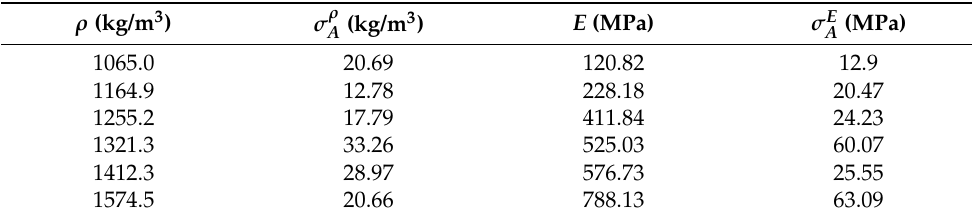
Figure 9. Approximate section describing the variance in the compressing stress value during the sample relaxation indicating the starting point A and the end point B of the linear regression for the selected sample characteristic with a density equal to 1412.3 kg/m 3 . Table 2. Young’s modulus values for selected dry ice sample